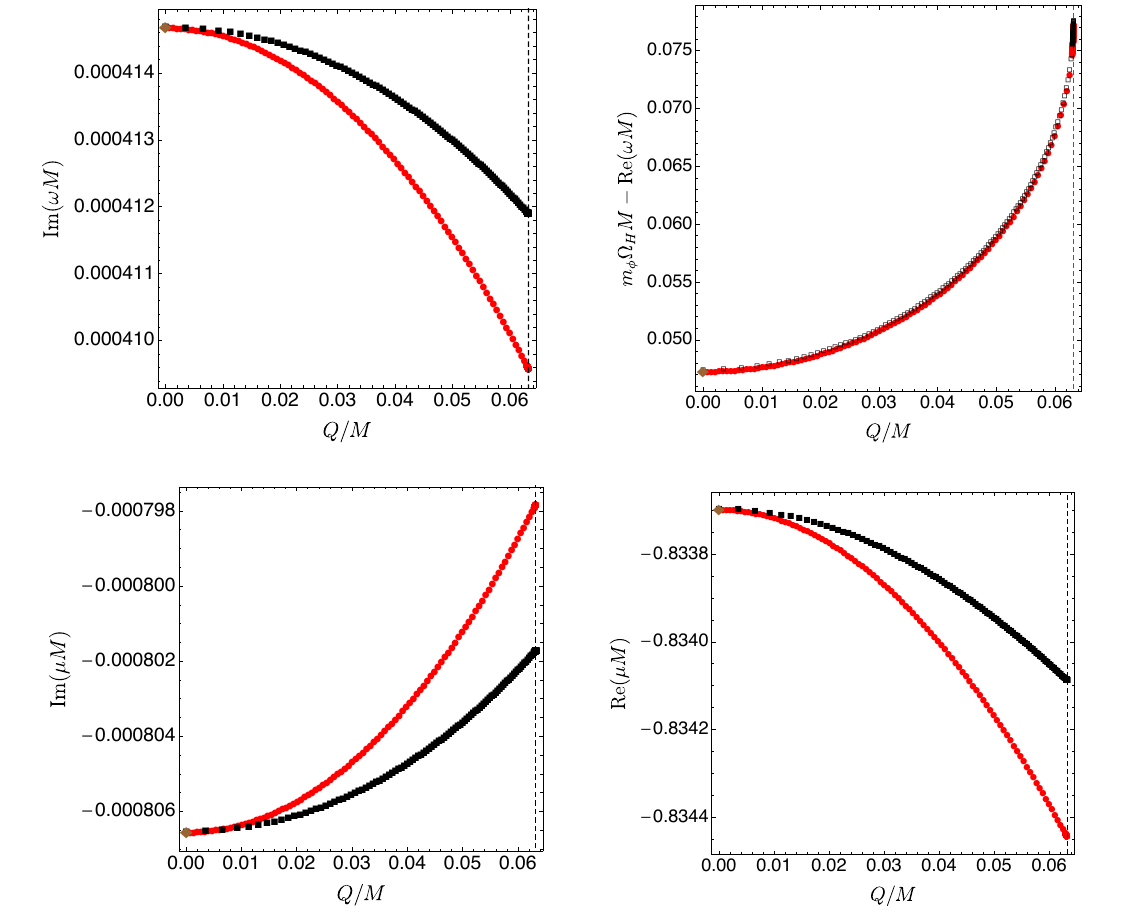
Figure 3 . Kerr-Sen vs. Kerr-Newman black holes: e(cid:11)ect of charge. Unstable Proca modes with mass mM = 0 : 51 and m (cid:30) = 1 for Kerr-Newman (red disks) and Kerr-Sen (black squares) black holes with J=M 2 = a=M = 0 : 998 as a function of the dimensionless hole charge Q=M . The upper panels describe the imaginary and real part of the dimensionless frequency !M , while the lower panels give the imaginary and real parts of the dimensionless angular eigenvalue (cid:22)M . The brown diamond at Q=M = 0 describes the Kerr solution already signalled also with a brown diamond in the plots of (cid:12)gures 1 and 2. The vertical black dashed line signals extremality which occurs at Q=M = 0 : 063213922517 for Kerr-Newman and at Q=M = 0 : 063245553203 for the Kerr-Sen black hole (so the two extremal vertical lines cannot be distinguished in the